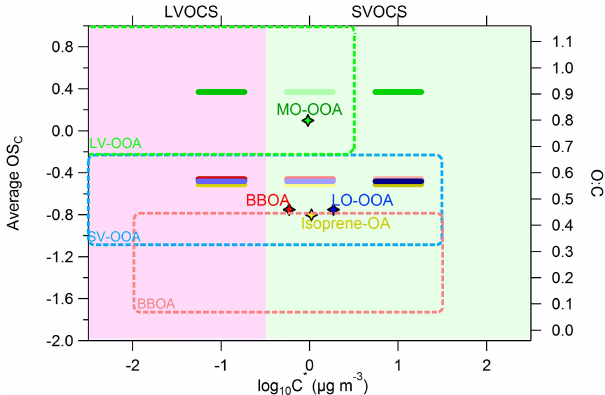
Figure 5. Average carbon oxidation state OS C (left y axis) and O : C ratio (right axis) versus the saturation concentration in terms of log 10 C ∗ . The horizontal bars are the volatility distributions of the SOAS PMF factors: MO-OOA (green), LO-OOA (blue), isoprene- OA (yellow) and BBOA (red). The darker the color of the horizontal bars the higher the mass fractional contribution for the correspond- ing C ∗ bin. The diamonds represent the average log 10 C ∗ value for a given PMF factor. The green, light blue and pink dashed areas are the locations of the LV-OOA, SV-OOA and BBOA PMF factors as proposed by Donahue et al.